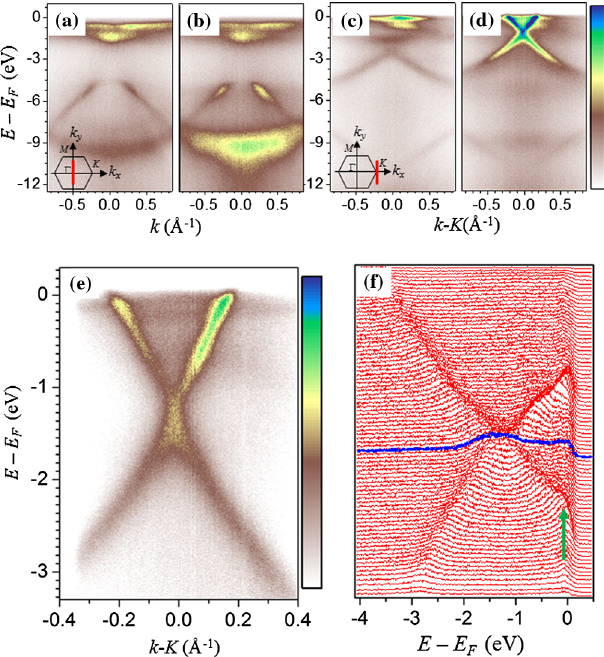
FIG. 5. Electronic band structures measured by ARPES of the (a),(c) as-grown graphene and (b),(d) Na-intercalated graphene, and (e),(f) high angular and energy-resolution measurements of the Na-intercalated graphene. (a),(b) Taken at the Γ point; (c),(d) taken at the K point. The data are measured along the red lines, as indicated in the insets. The color-scale bars in (a) and (b) are the same. (e) Band structure around the K point near the Fermi energy, taken along the direction perpendicular to the Γ - K . (f) Photoemission intensity profiles as a function of BE (energy- distribution curves).